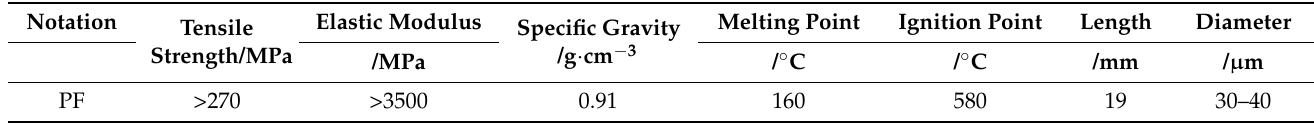
Table 3. Physical properties of polypropylene fiber (PF).